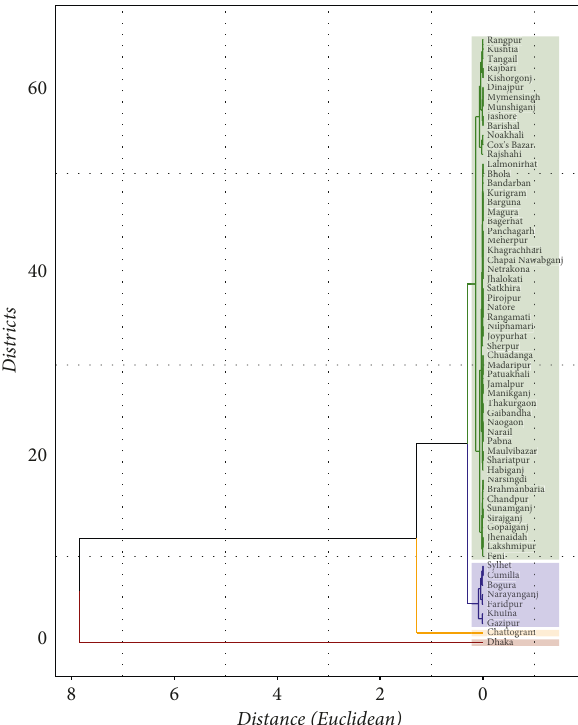
Figure 1: Cluster of districts based on COVID-19 cases.